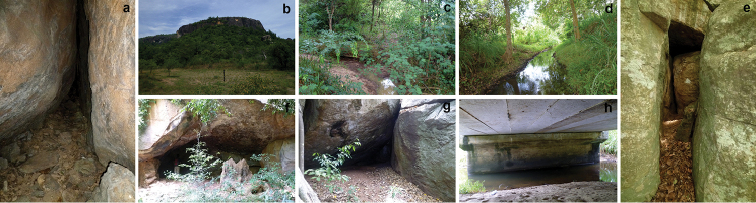
Habitats of bats in the peripheral areas of Maduru-Oya National Park. a a cave in Dananjaya Gala b rocky outcrops surrounded by forests c scrublands with temporary pools d small canal inside the forest e a cave nearby the Maduru-Oya reservoir f a historical cave in Damminna g a cave nearby Henanigala h under a large bridge.